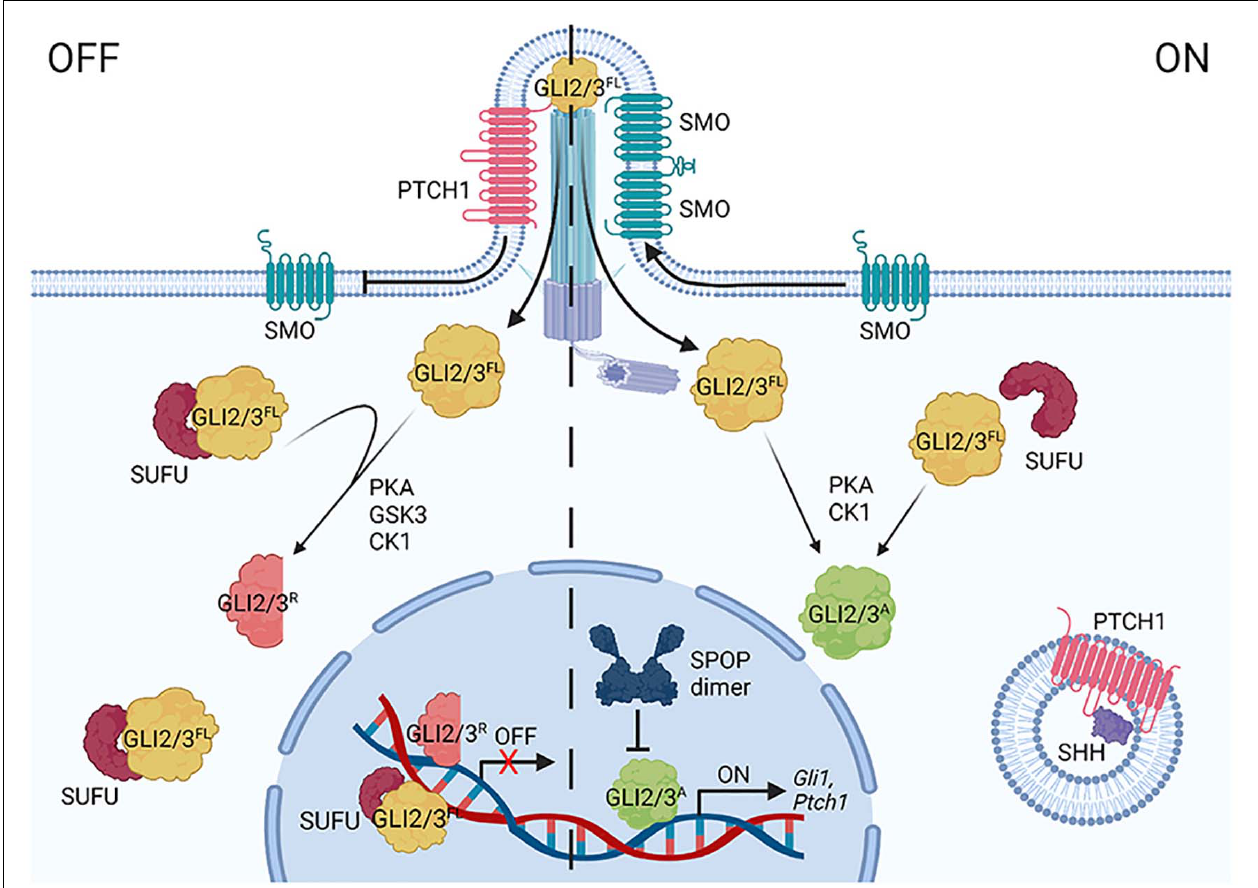
FIGURE 2 | A simplified diagram of the vertebrate HH signaling pathway. In the off state (left), Patched1 (PTCH1) represses Smoothened (SMO) by inhibiting its entry into the primary cilium (PC). GLI2/3 effectors are targeted for partial processing into repressor forms (GLI2/3 R ) following sequential phosphorylation via PKA, GSK3( β ), and CK1. SUFU binds GLI2/3 FL in the cytoplasm and nucleus. SHH binding to PTCH1 (right) triggers its endocytosis, enabling SMO to oligomerize and enrich in the PC. GLI2/3 proteins are activated (GLI2/3 A ) through alternate phosphorylation events (PKA, CK1), causing dissociation from SUFU and entry into the nucleus to induce target genes (including Gli1 and Ptch1 ). CRL3-SPOP tunes the GLI response by targeting nuclear GLI2/3 A for